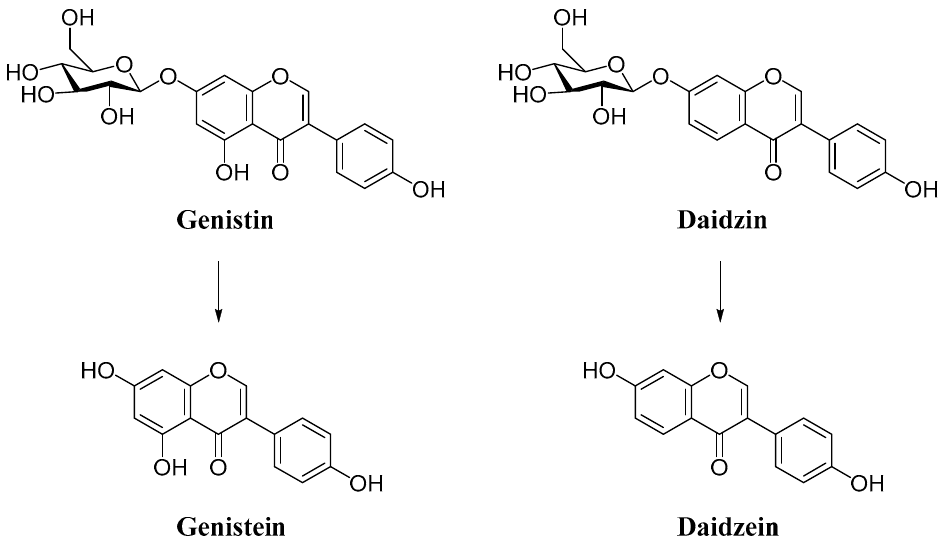
Figure 1. Chemical structures of genistin, genistein, daidzin and daidzein. Choosing the right extraction method and parameters are the most important stages in the development of nutraceuticals from natural resources. Different extraction processes contribute to the extraction efficiency of the active ingredient from the solid matrix